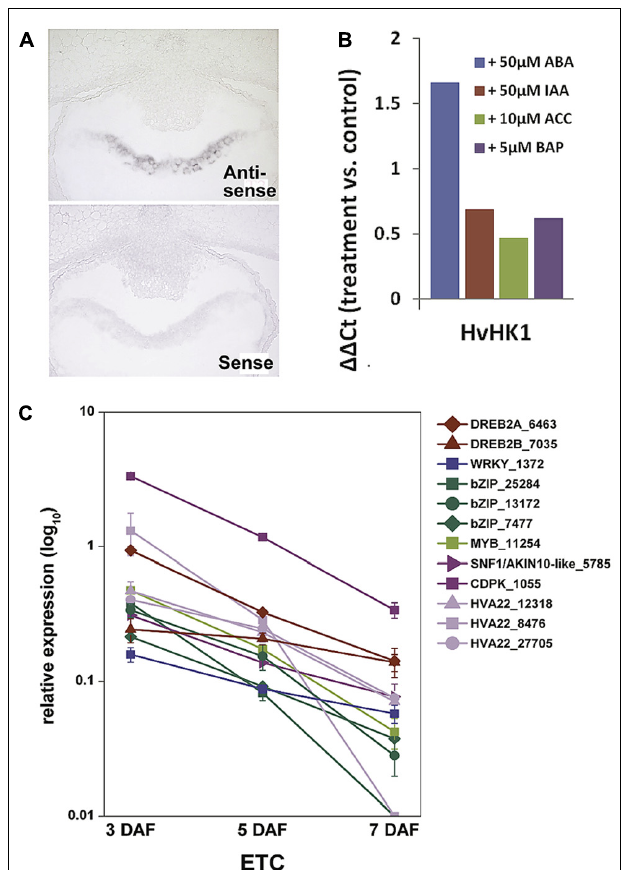
FIGURE 4 |Transcript analyses of HvHK1 and putatively interacting transcription factors. (A) In situ hybridization specifies the expression of HvHK1 in 3 DAF grains exclusively in the part of the cellularizing endosperm facing the nucellar projection. (B) Transcriptional response of HvHK1 to hormones was analyzed by in vitro experiments. Grains were incubated in MS medium supplemented with the indicated concentrations of hormones for 16h.The (cid:2)(cid:2) Ct value was calculated from qRT-PCR analysis and represents the log 2 -ratio compared to control conditions. (C) Expression profiles of putative interacting transcription factors and ABA signaling elements in ETCs.Transcript levels were determined by qRT-PCR analyses and relative expression is given in the log 10 scale.Transcripts numbers indicate the contig identifier in the 454 transcriptome assembly [Image in C is reproduced fromThiel etal.